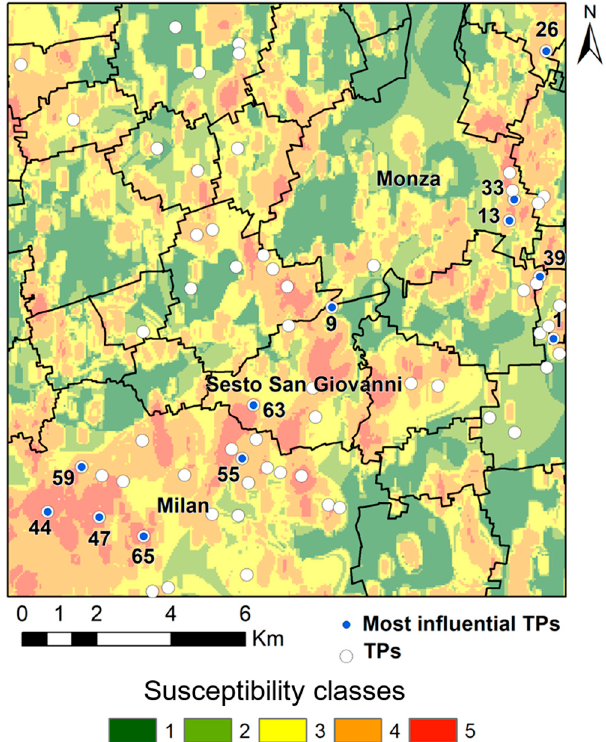
Figure 10. Location of the most influential TPs (blue dots) in the study area, overlaid on the susceptibility map (in transparency). Susceptibility degree increases from green (class 1) to red (class 5) colors.